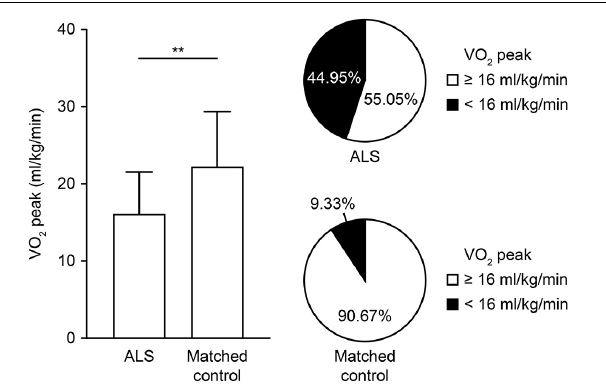
FIGURE 2 | Comparison of exercise capacity measured by the CPET in controls and patients with ALS. The degree and proportion of impaired exercise capacity are depicted in controls and patients with ALS. The VO 2 peak (ml/kg/min) represents the exercise capacity, and the impaired exercise capacity is defined by a VO 2 peak < 16 ml/kg/min. ** p < 0.01. ALS, amyotrophic lateral sclerosis; CPET, cardiopulmonary exercise testing; VO 2 peak, oxygen uptake at peak